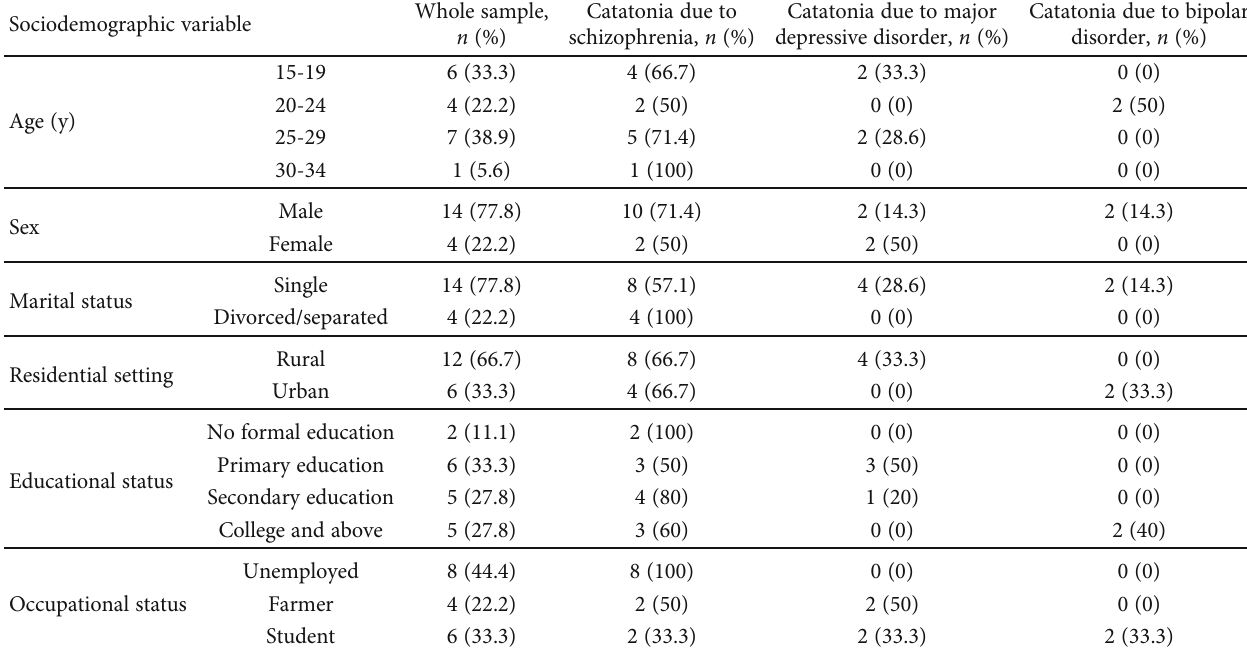
Table 1: Sociodemographic characteristics of